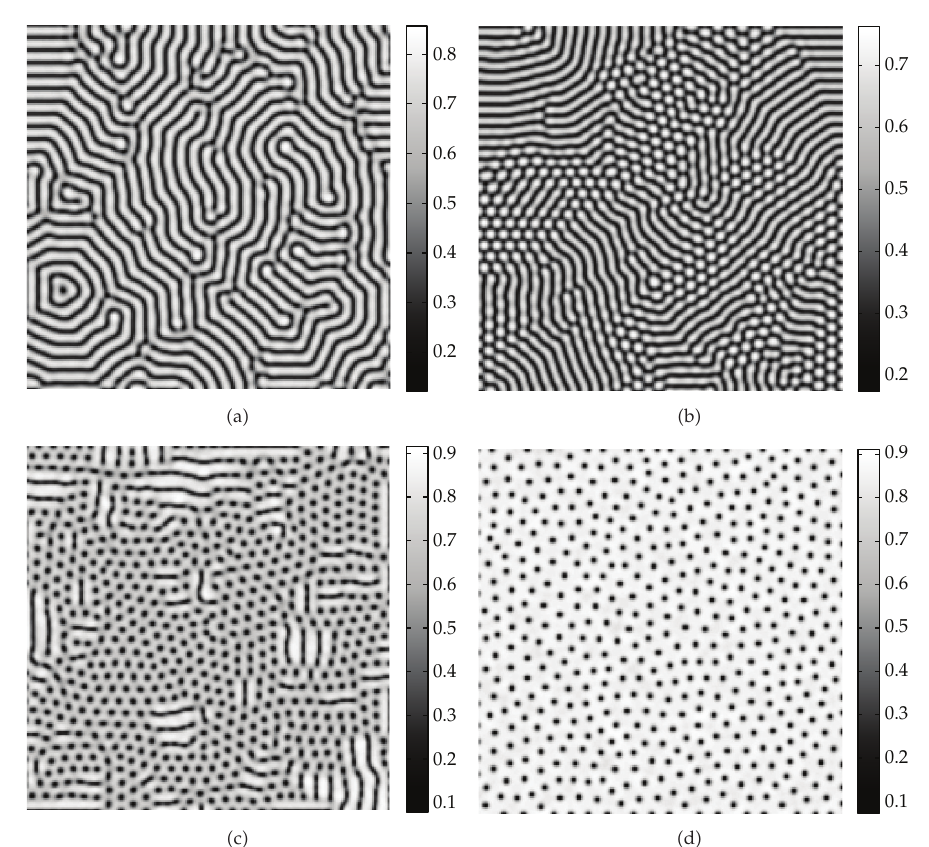
Figure 4: Four types of patterns obtained with model (cid:7) 1.1 (cid:8) for 100000 iterations. (cid:7) a (cid:8) Pattern α : (cid:7) D 12 ,r (cid:8) (cid:6) (cid:7) − 0 . 04 , 0 . 00574 (cid:8) . (cid:7) b (cid:8) Pattern β : (cid:7) D (cid:8) (cid:6) (cid:7) 0 . 152 , 0 . 0882 (cid:8) . (cid:7) c (cid:8) Pattern γ : (cid:7) D 12 ,r δ : (cid:7) D 12 ,r (cid:8) (cid:6) (cid:7) 0 . 2 , 0 . 01 (cid:8)